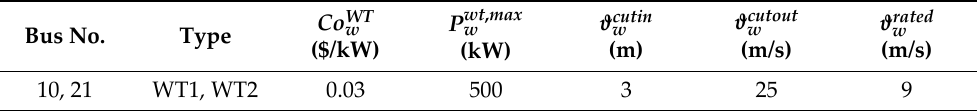
Table 6. WTs’ data.